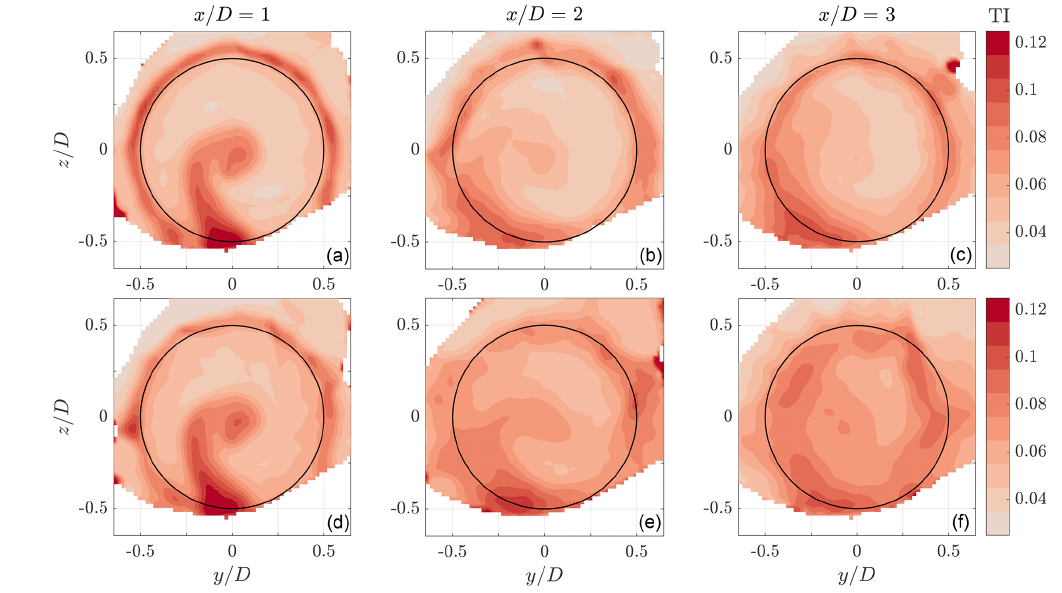
Figure 8. Turbulence intensity (TI) contours at multiple locations in the wake of a turbine operating with baseline control (a–c) and DIC with St = 0 . 24 (d–e)